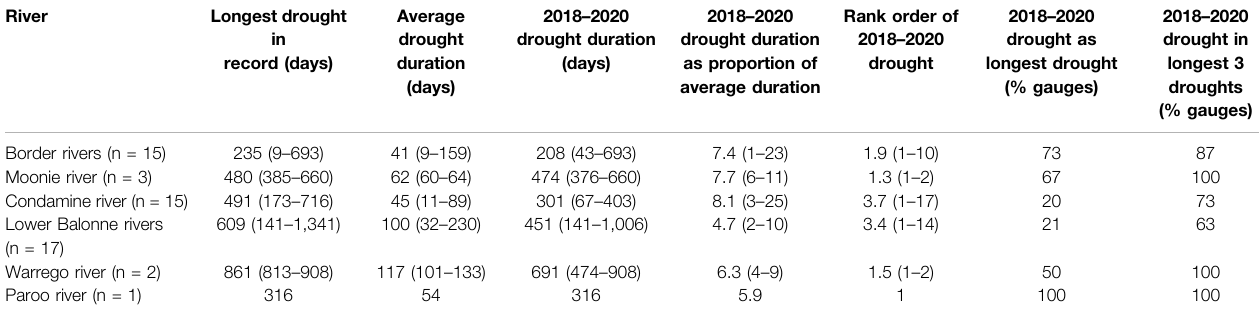
TABLE 1 | Summary drought statistics for each QMDB river based on available stream gauge data for long term records and the 2018 – 2020 drought. For this summary, droughts are identi fi ed as consecutive days with zero fl ow recorded in gauge records, with means and ranges (minimum-maximum) of values for all gauges in each catchment (indicated as n). The rank order of the 2018 – 2020 drought is based on its duration in comparison to all other droughts in each gauge record. Data for individual gauges are presented in Supplementary Table S1 .